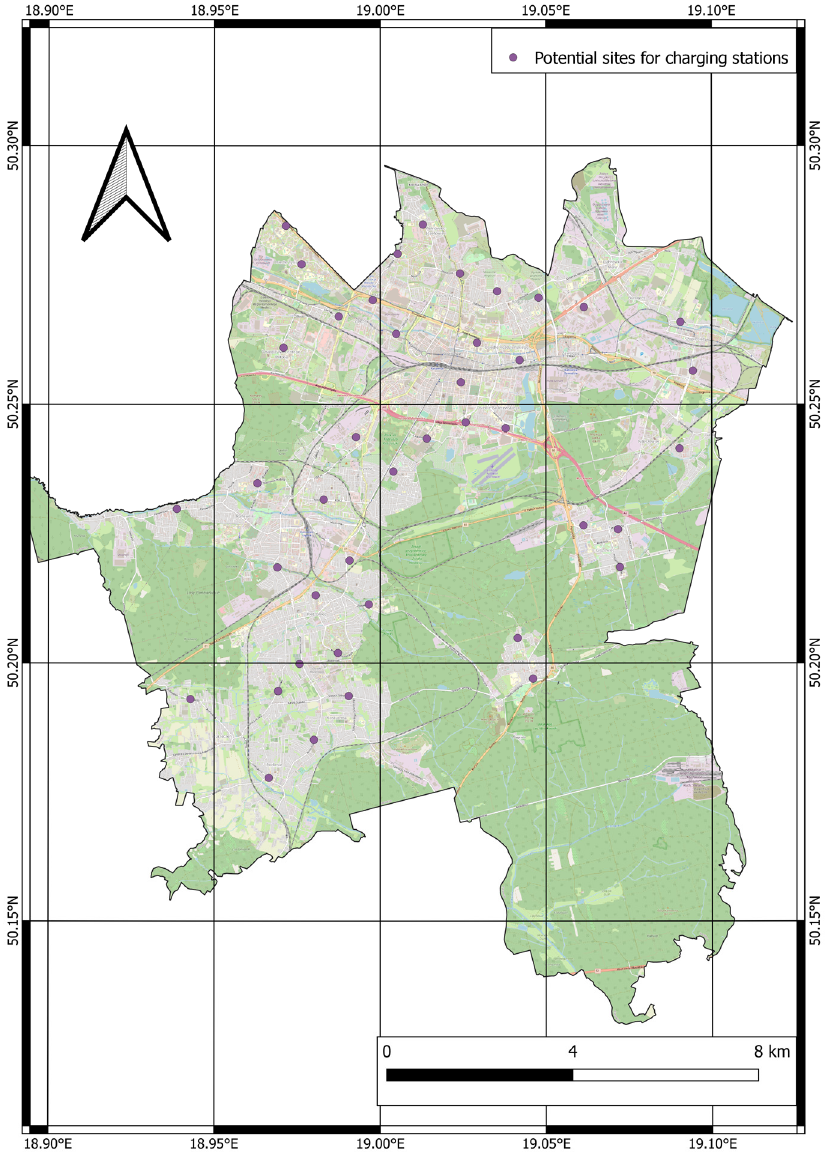
Figure 8. Location of 42 prospective sites for the company to install new in-house charging stations.